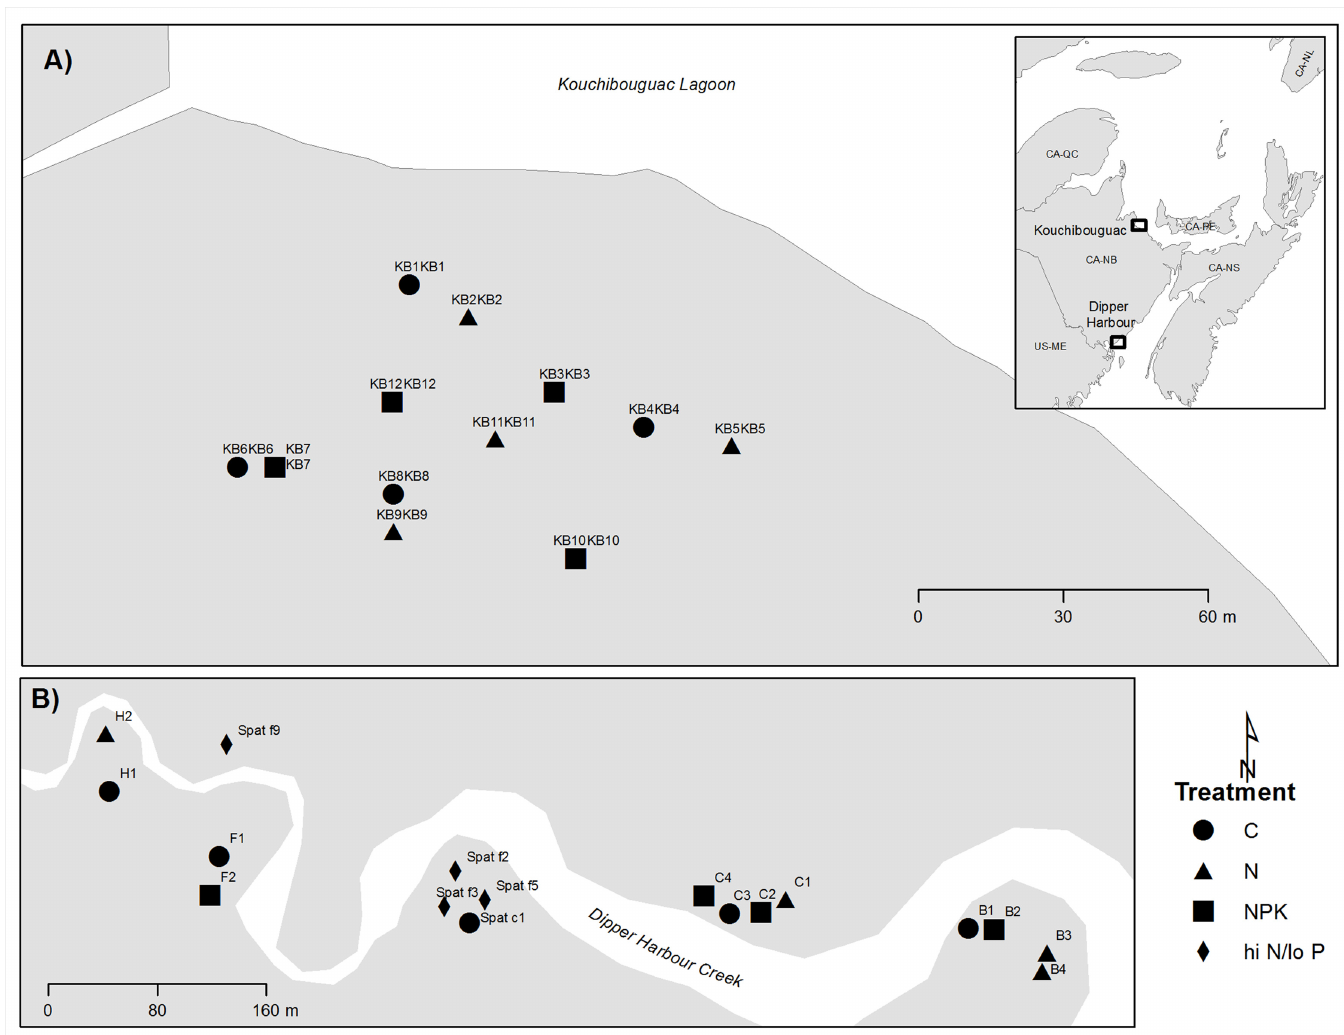
Fig 1. Schematic map of gas flux sample locations. (a) Sample locations at the Kouchibouguac marsh. (b) Sample locations at the Dipper Harbour marsh. Each symbol represents a chamber location. Inset shows location of both sites on the New Brunswick coast. C = control, N = fertilizer with only nitrogen applied, NPK = fertilizer with nitrogen, phosphorus and potassium applied, hi N/lo P = fertilizer with high levels of